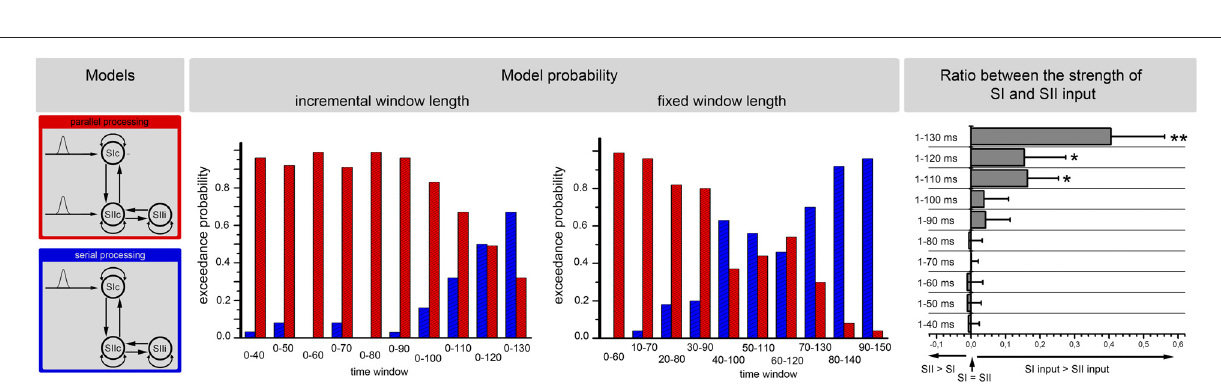
FIGURE 7 | The results of the BMS for the stimulus initiation. The left side of the image illustrates the structures of the two models (i.e., parallel processing and serial processing). The middle illustrates the EP of these two models for 10 different time windows. The analysis was performed for incremental time windows (left side) and also for fixed time windows (right side of the middle part). The right side of the image illustrates the results of the posterior estimates for the most probable model (parallel input until 110 ms and serial input for the last two epochs) at the level of input strength. The input strengths in the SI and the SII are shown for the 10 different time windows. The x -axis represents the ratio between the strengths of the SI and SII inputs. Positive values represent stronger inputs in the SI than in the SII. The error bars represent the standard deviation. Significant differences between the SI and SII inputs are marked with “ ∗ ” ( p < 0.01) or “ ∗∗ ” ( p <